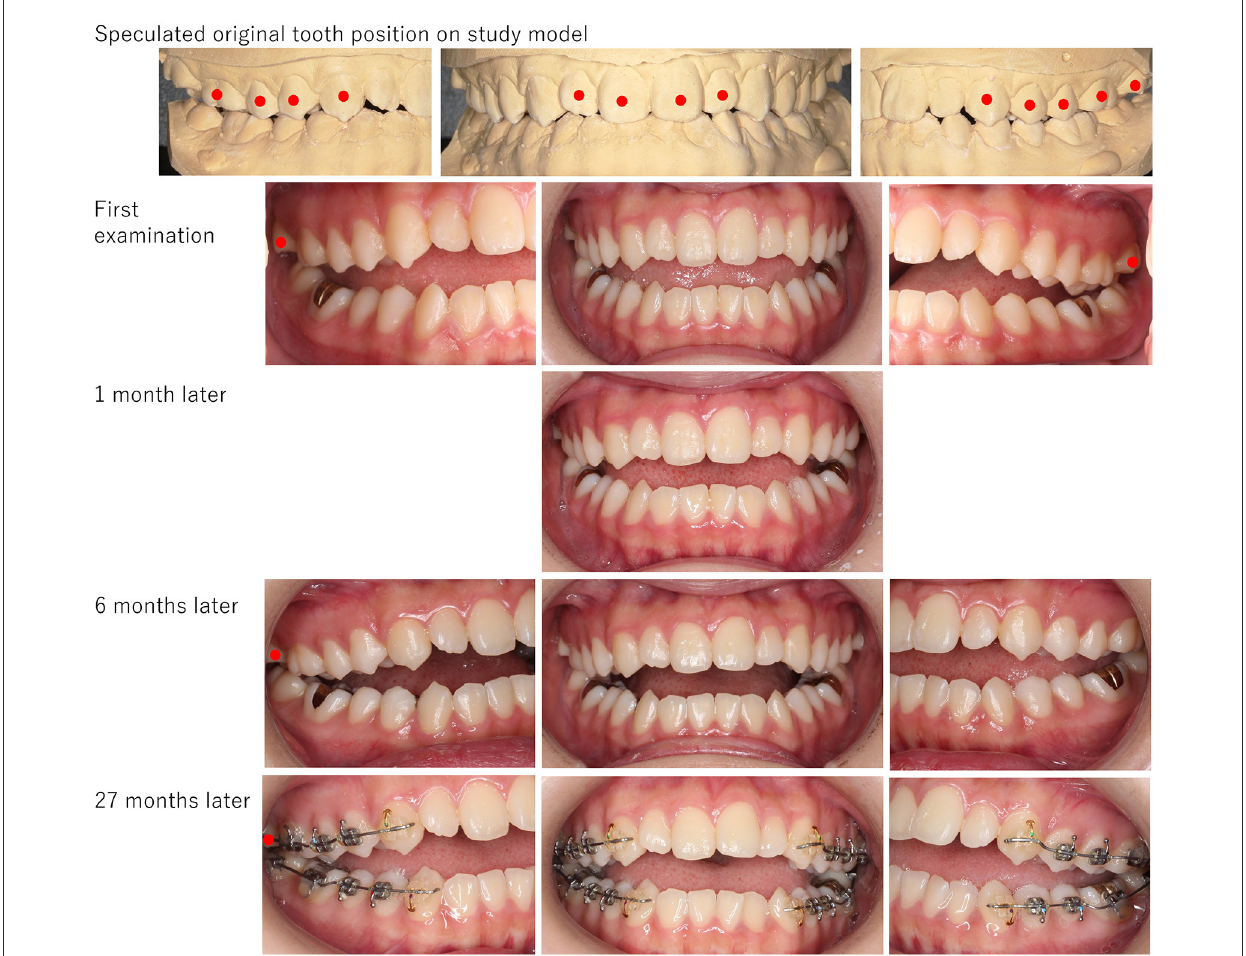
FIGURE5 The picture of a patient (Case No. 11). Open bite was obvious, and occlusal contact was observed only partially on the second molars. Tight occlusal contact was found on her study model. Drug-induced open bite never improved even after stopping psychotropic medications. The orthodontic treatment for the intrusion of the second molars started 27 months later. Red circles indicate teeth that have occlusal